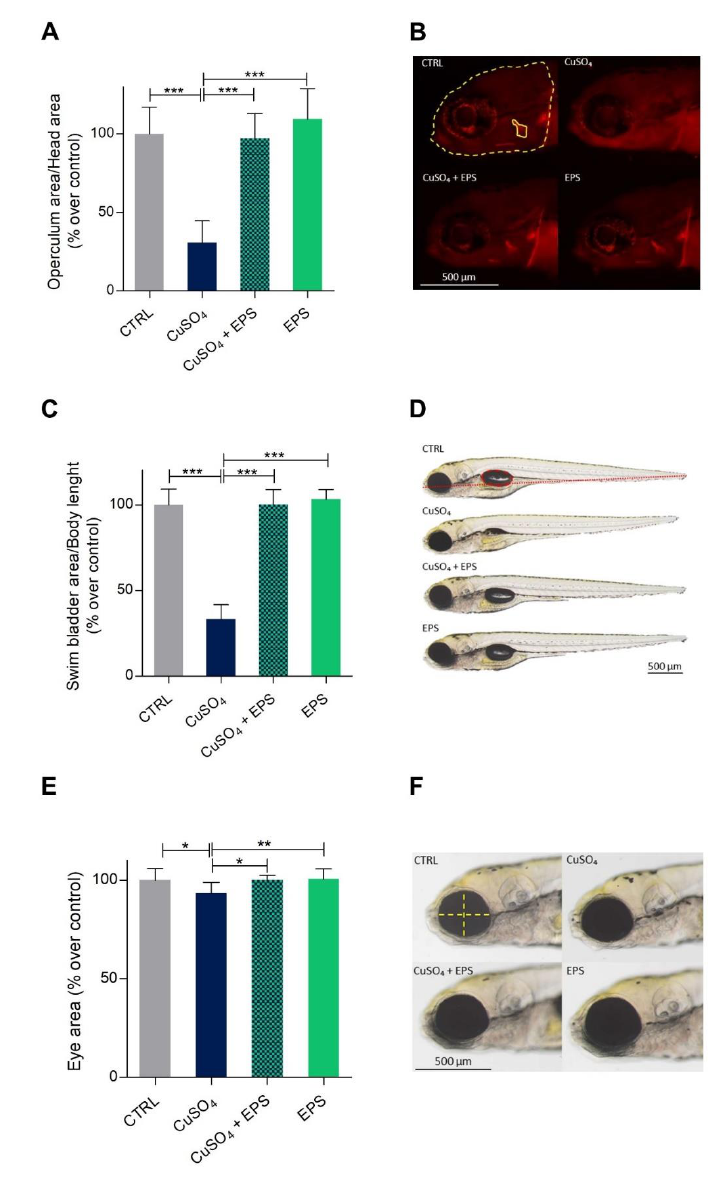
Figure 4. Recovering of normal developmental parameters after copper induced inflammation with Phormidium EPS treatment. ( A ) Reduced operculum mineralization due to copper was recovered after treatment with EPS. Operculum area was determined by normalization with the area of the head according to Tarasco and co-worker (2017) [46]. ( B ) Picture of alizarin red S (AR-S) stained 5 dpf zebrafish larvae’s head showing the area of the head and the operculum evaluated through morphometric analysis. ( C ) CuSO 4 ·5H 2 O treated larvae showed consistently a deflated swim bladder at 5 dpf, which was partially recovered after treatment with EPS. ( D ) Micrographs showing reduced inflation of swim bladder induced by CuSO 4 ·5H 2 O exposure and rescue due to EPS treatment. Wild-type larvae of the same ages are shown for comparison. In the zebrafish control image, the swim bladder is outlined by a red dashed line, whereas the body length by a dotted line. Scale bar = 500 µ m. ( E ) CuSO 4 · 5H 2 O treated larvae showed significant reduction of eye dimension at 5 dpf, which was recovered after treatment with EPS. ( F ) Micrographs showing reduced eye dimension after CuSO 4 · 5H 2 O exposure and rescue due to EPS treatment. Wild-type larvae of the same ages are shown for comparison. Scale bar = 500 µ m. The data represent the mean ± SD of three independent experiments conducted with 12–15 larvae. Statistical analysis was performed using GraphPad Prism 7 (one-way ANOVA followed by Tukey’s multiple comparison test). Statistical significance: * p < 0.05, ** p < 0.01, *** p ≤